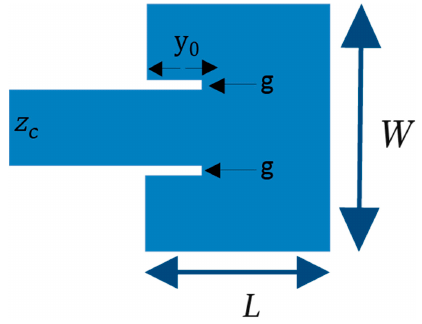
Figure 5. Antenna with inset feed.